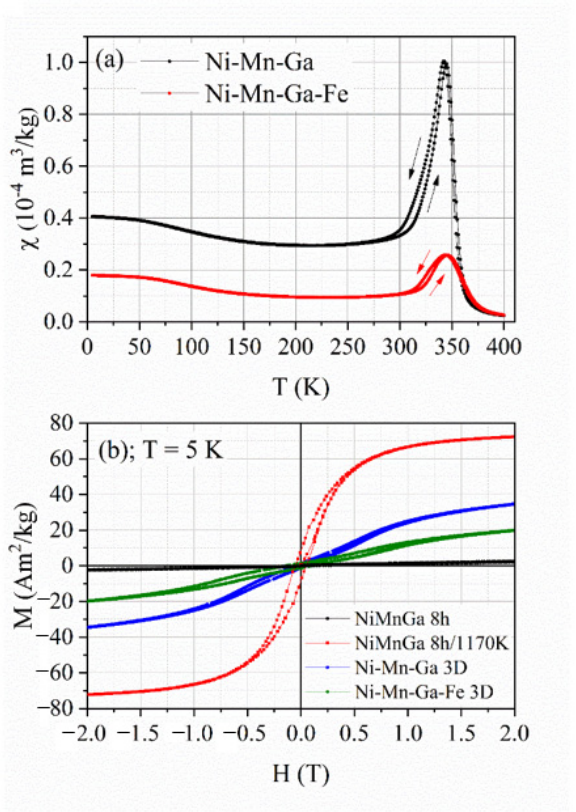
Figure 11. Magnetic susceptibility vs. temperature ( a ) and magnetic field dependence of magnetization ( b ) in as milled, milled and annealed and selected laser melted Ni-Mn-Ga and Ni-Mn-Ga-Fe powders.